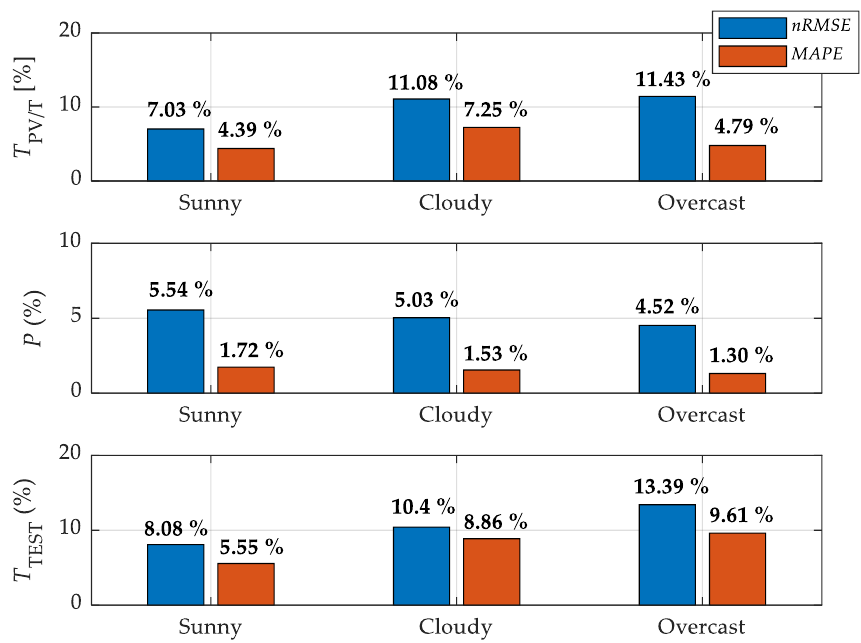
Figure 13. Validation of the dynamic model of PV/T collector and TEST with measurements using nRMSE and MAPE method ( T PV/T , P , T TEST ) based on three different weather conditions: sunny, cloudy, and overcast.